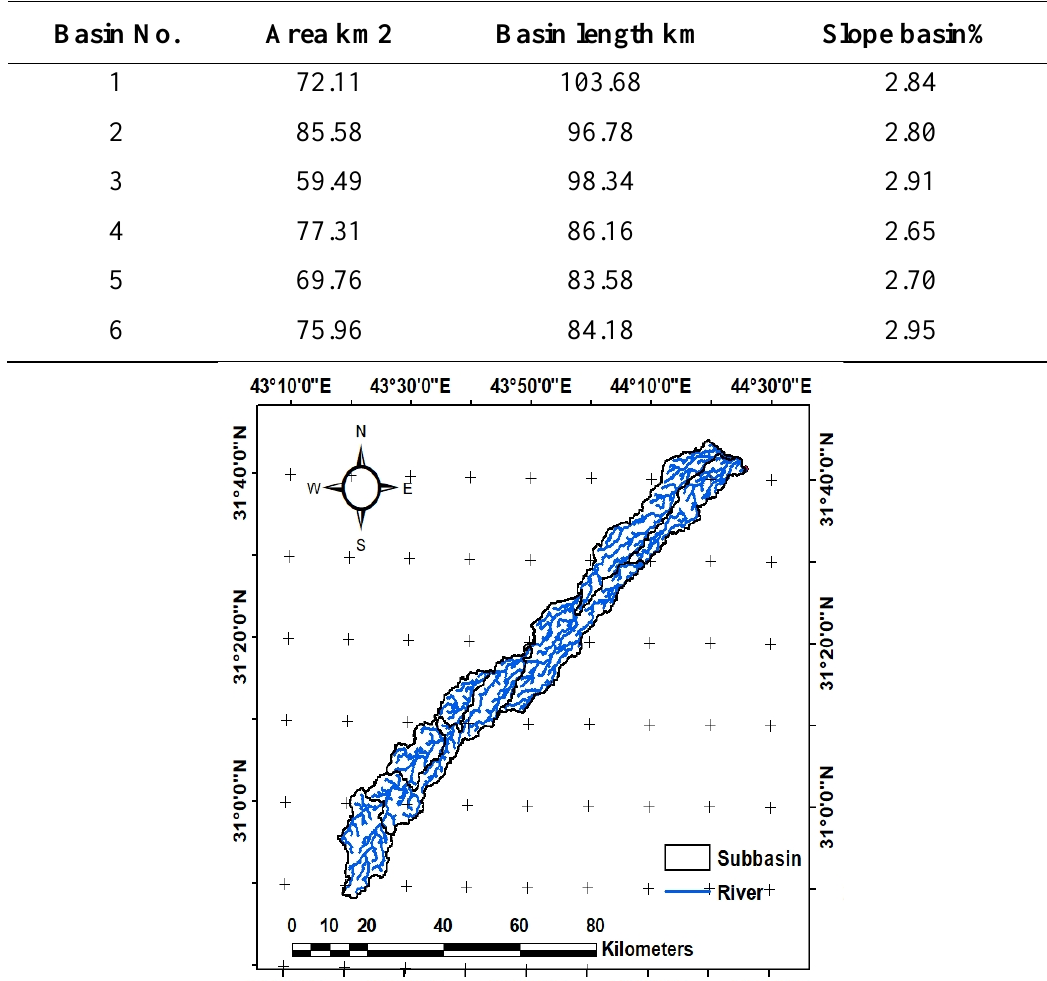
Fig. 7. The sub-basins of basin 1 . Table 2. The details of sub-basins of basin 1 .